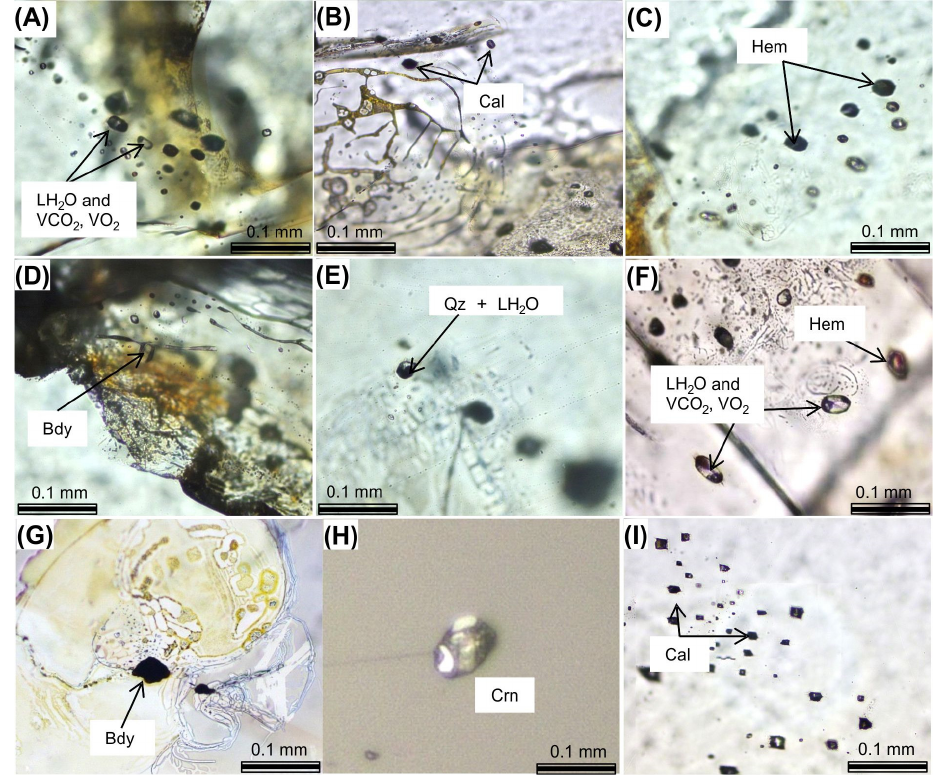
Figure 3. Representative inclusions found in placer zircon megacrysts: ( A ) fluid inclusions (LH 2 O: aqueous H 2 O VCO 2 and VO 2 : vapor CO 2 and O 2 , respectively); ( B ) Calcite (Cal); ( C ) hematite (Hem); ( D ) baddeleyite (Bdy) within tubular channels; ( E ) quartz (Qz) within tubular channels; ( F ) hematite and fluid (Hem + Fld) within bifurcating cavities and vesicles; ( G ) baddeleyite (Bdy) in tubular channels, bifurcating cavities, and vesicles; ( H ) corundum (Crn); and ( I ) calcite (cal) inclusion groups and along chains.